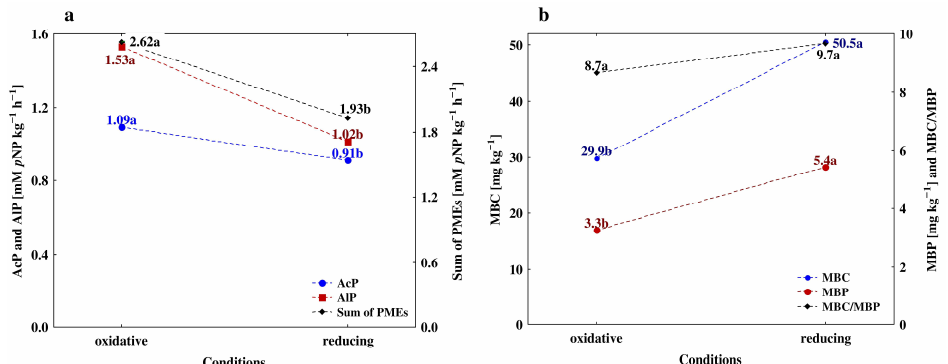
Figure 4. Effect of oxidative and reducing conditions on the AcP, AlP activities and the sum of PMEs ( a ), and on the microbial biomass C and P content (MBC, MBP) and the ratio of MBC/MBP ( b ). Horizons with the expected reducing conditions were compared with the oxidative horizons, lying at a nearing depth (three the deepest horizons in profile no 1, 2 and 4 with three of the deepest layers in profiles no 3 and 5, respectively). Values for each property marked with different letters are statistically different at p < 0.05. Table 5. Root mass, length and surface area in the considered